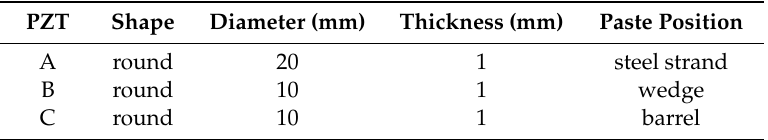
Table 1. Parameters of PZTs.